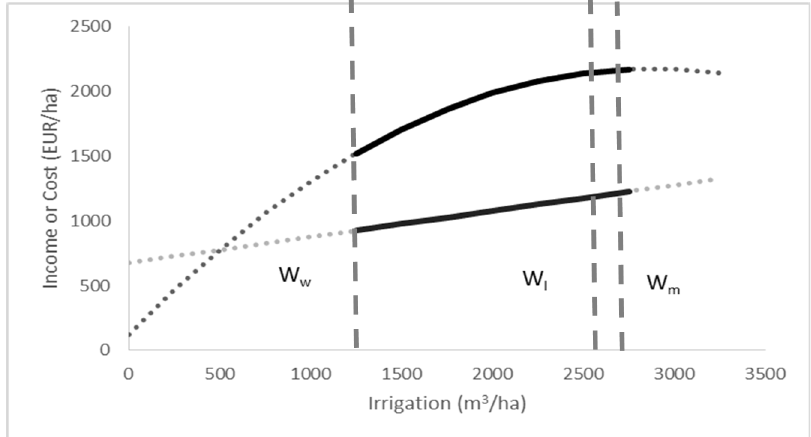
Figure 1. Illustrative example of farmer #42. Values of net income and total cost per hectare for three solutions: maximum yield ( W m ), maximum return to land ( W l ) and maximum return to water ( W w ). Water-yield relationship is obtained by eliciting farmers’ subjective beliefs.